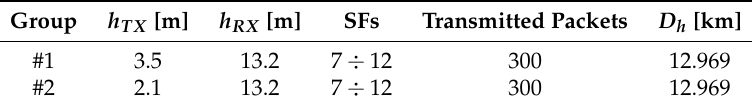
Table 2. Antennas heights, exploited SFs, number of transmitted packets and distance of the horizon from the receiver antennas for each trial